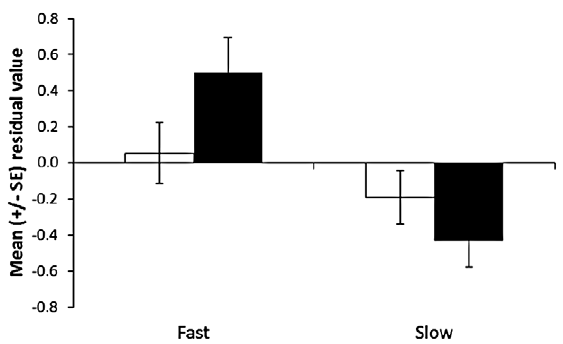
Figure 3. Mean proportion change in activity from the pre- stimulus baseline for large and small tadpoles conditioned to recognize a predatory salamander, maintained on either a fast or slow growth trajectory for 7 days and tested for their response to water (white bars) or salamander odour (black bars).